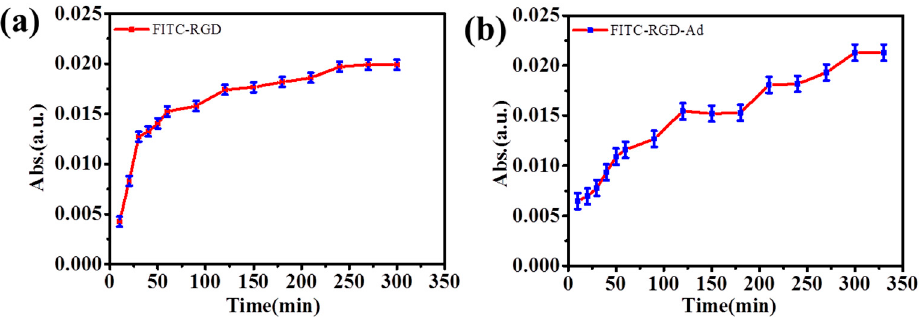
Figure 5. The release curves of ( a ) FITC-RGD and ( b ) FITC-RGD-Ad from (PAH/SiO 2 ) 1 /(PAH/HA- CD) 7 /(PAH-SiO 2 ) 1 /(PAH/HA-CD) 7 multilayer films.